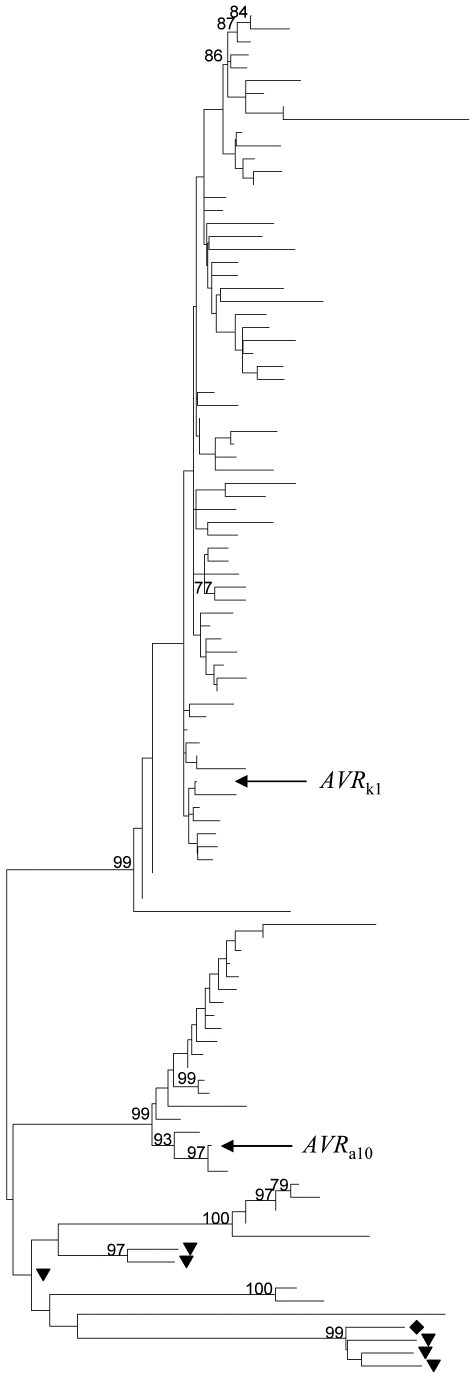
Neighbor-joining consensus tree showing the relationship between AVR
k1 homologs from powdery mildew genomes.
B. graminis sequences were retrieved from an nrdb90 database as described in the text; near-identical sequences were removed for clarity. The figure shows 105 amino acid sequences, including AVR
k1, AVR
a10 and 96 ORFs predicted from Bgh, six ORFs predicted from the Erysiphe pisi genome (marked with a triangle) and one ORF predicted from the Erysiphe (Golovinomyces) orontii genome (the closest homologue to AVRk1 of the six found, marked with a diamond). Bootstrap support (1,000 replicates) is shown if higher than 70%.